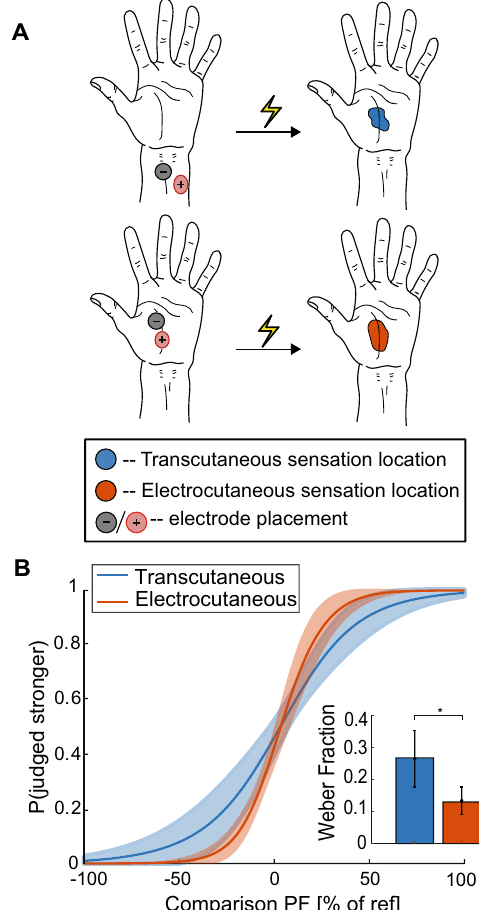
Figure 3. Comparison of transcutaneous stimulation (n = 6, blue) and electrocutaneous stimulation (n = 7, orange). ( A ) Placement of electrodes and the sensory field of evoked percepts. Both forms of stimulation had similar sensory fields despite different electrode locations. ( B ) Psychometric functions relating intensity discrimination performance to changes in pulse frequency. Discrimination performance is given as the percentage of test stimuli identified stronger. Pulse frequency (PF) is reported as a percentage of the reference pulse frequency. Inset shows the Weber fraction for each form of stimulation as mean ± standard error of the mean. Electrocutaneous stimulation (red) had a significantly smaller Weber fraction than transcutaneous stimulation (blue) ( p < 0.05, unpaired